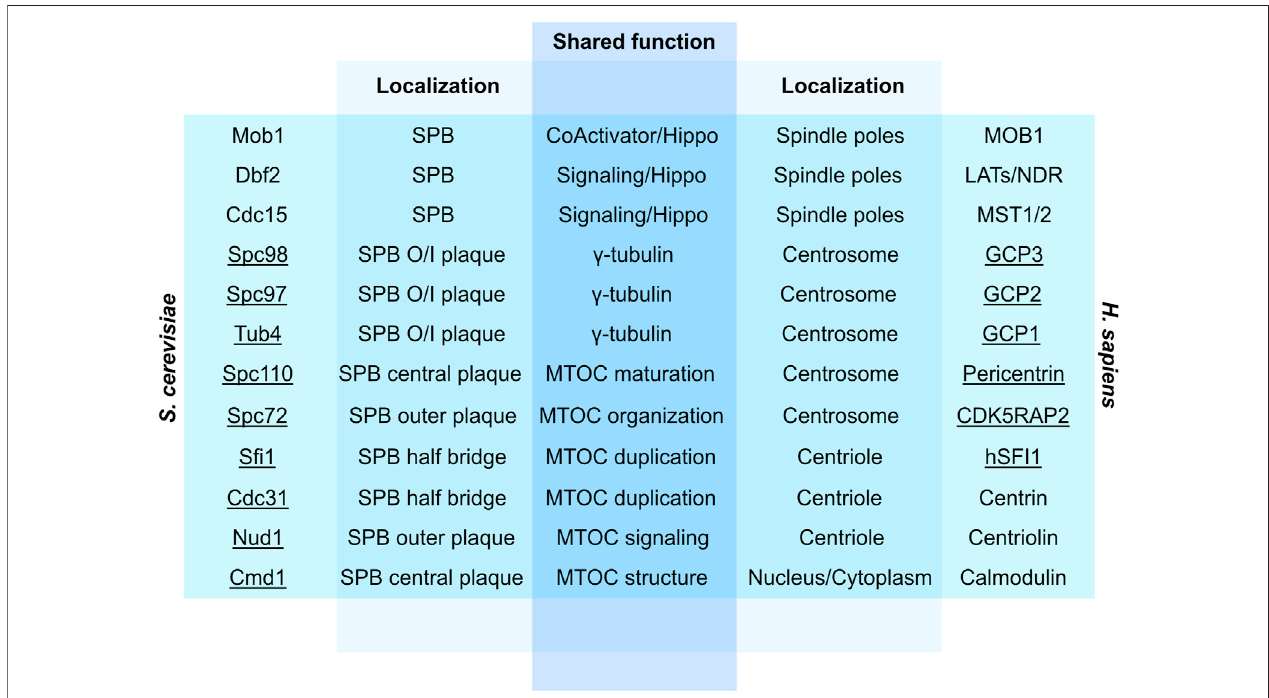
FIGURE3| OverviewofconservedyeastandhumanproteinsinvolvedinMTOCstructure,signaling,duplicationandfunction.Underlinedarephysicalconstituents of centrosomes/SPBs. SPB, Spindle pole body; O/I, Outer/Inner; Hippo, Hippo pathway; Pericentrin, Kendrin/CG-NAP (Fraschini, 2019).